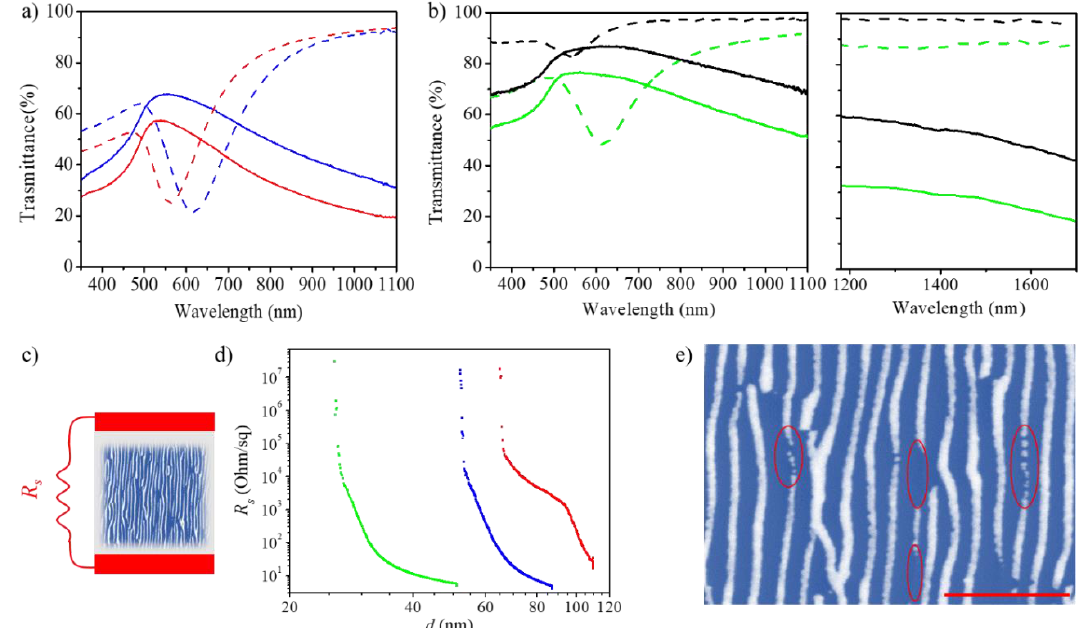
Figure 2. ( a , b ) Optical extinction spectra of quasi-1D Au nanostripe arrays confined on the wide and on the narrow facets, respectively, as sketched in Figure 1d,e. The spectra were recorded for the longitudinal (TE-continuous lines) and transversal (TM-dashed lines) polarization of the UV-VIS-NIR illumination beam, with respect to the nanostripes’ long axis. In panel ( a ) the nanostripes’ aspect ratio h / w was increased from 0.21 (blue spectra) to 0.28 (red spectra), by increasing the height h from 22 nm to 30 nm; in panel ( b ), h / w was increased from the green to the black curve by decreasing the width of the nanoantennas; ( c ) sketch of the circuit exploited for measuring the sheet resistance ( R s ) parallel to the main axis of the nanostripes (size of the circuit: 2 × 2 mm 2 ); ( d ) plot of R s measured in-situ during the growth of Au nanoantennas at θ 2 = 50 ◦ (green curve), 60 ◦ (blue curve) and 70 ◦ (red curve) respectively; and ( e ) SEM image of Au nanostripe arrays confined on the narrow facets under glancing condition ( θ 2 = 80 ◦ ): a strong shadowing e ff ect is observed at the inter-ripple connection (red circles) with no gold or disconnected nanoclusters. These regions limit the electrical conductivity at the early stages of the Au evaporation process. The scale bar corresponds to 1 µm.